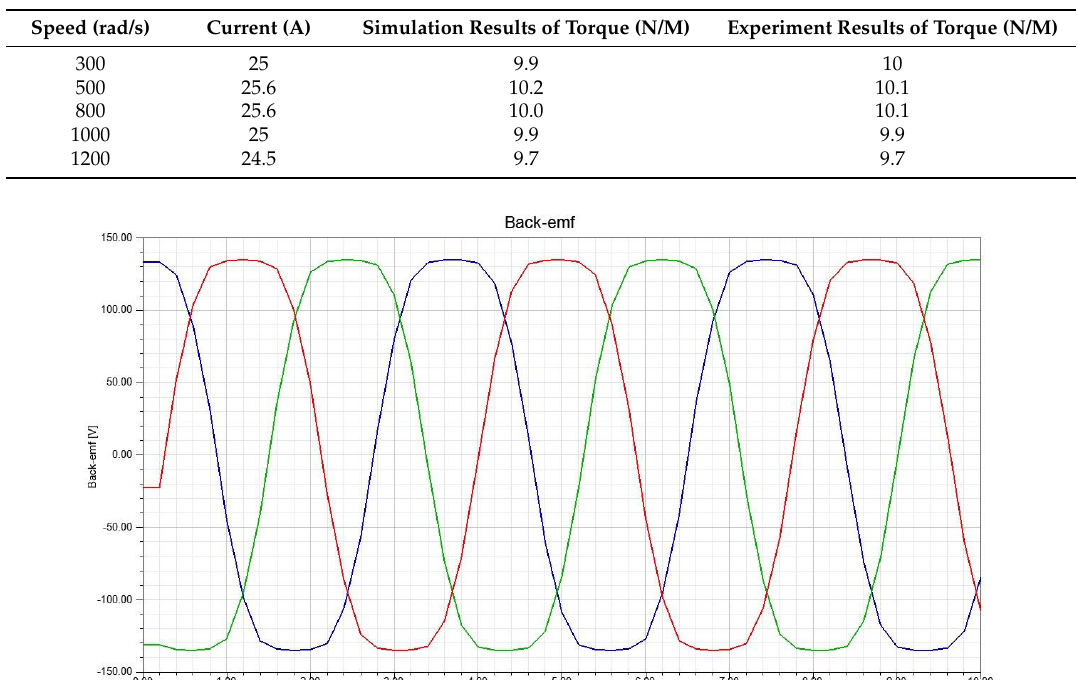
Table 10. Electromagnetic torque under different phase current.